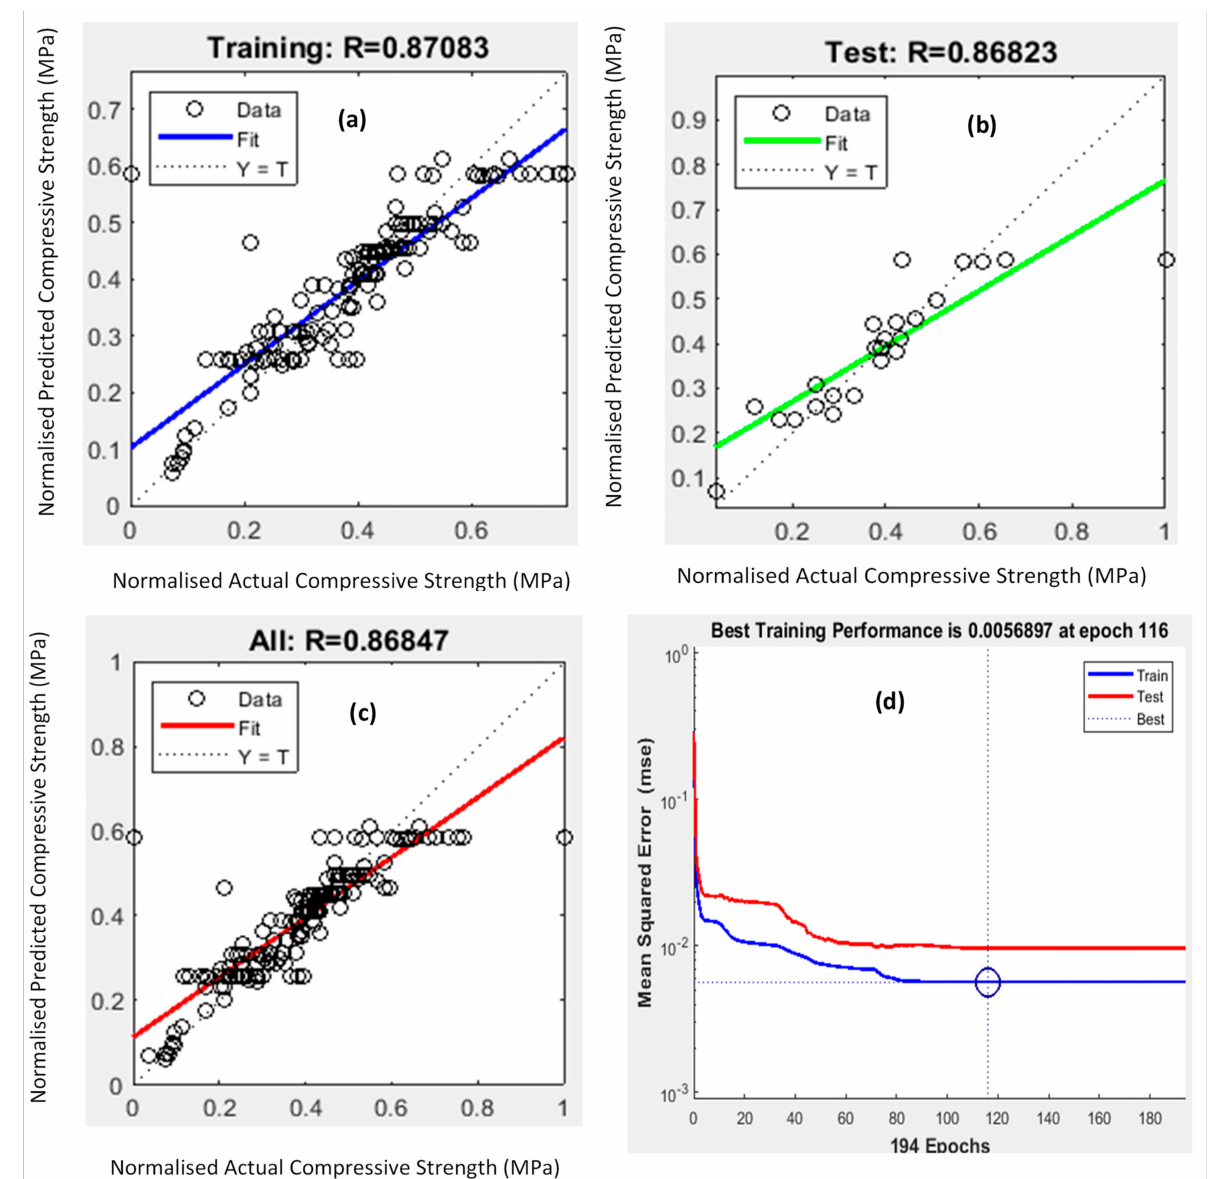
Figure 3. Performance of the artificial neural network (ANN) model based on ( a ) the training dataset; ( b ) test dataset; ( c ) all datasets; and ( d ) mean squared error for 8 hidden neurons and the Bayesian Regularization training